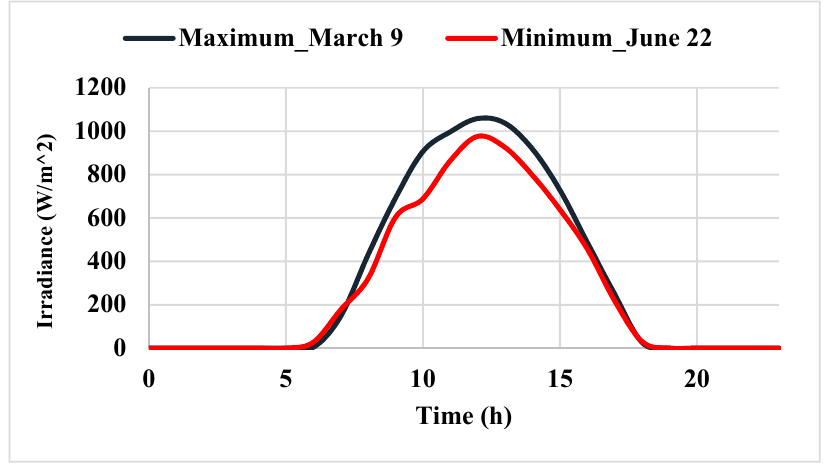
Figure 7. Solar irradiance of maximum and minimum irradiance